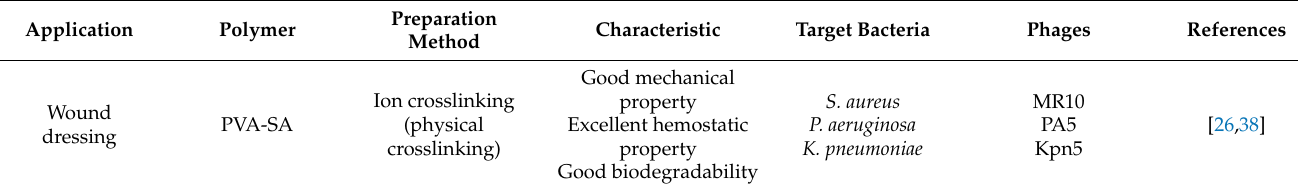
Table 1. Application and preparation of hydrogels used for delivering